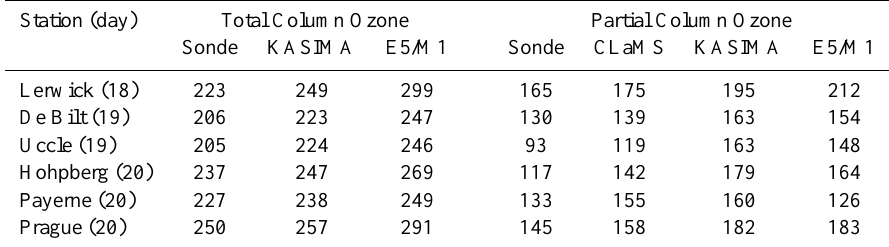
Fig. 9. Total ozone column in DU for 16 to 18 (top row) and 19 to 21 (bottom row) January 2006, 12:00UT, simulated by E5/M1; sounding stations are marked either by red stars (no measurement) or by red circles (total column measurement available, circles filled in respective colour code for Dobson Units). Table 4. Total and partial ( 2 = 350 to 700K) ozone columns in Dobson Units (DU) as measured and simulated (for 12:00UT) on the days of minimum ozone at the six ground